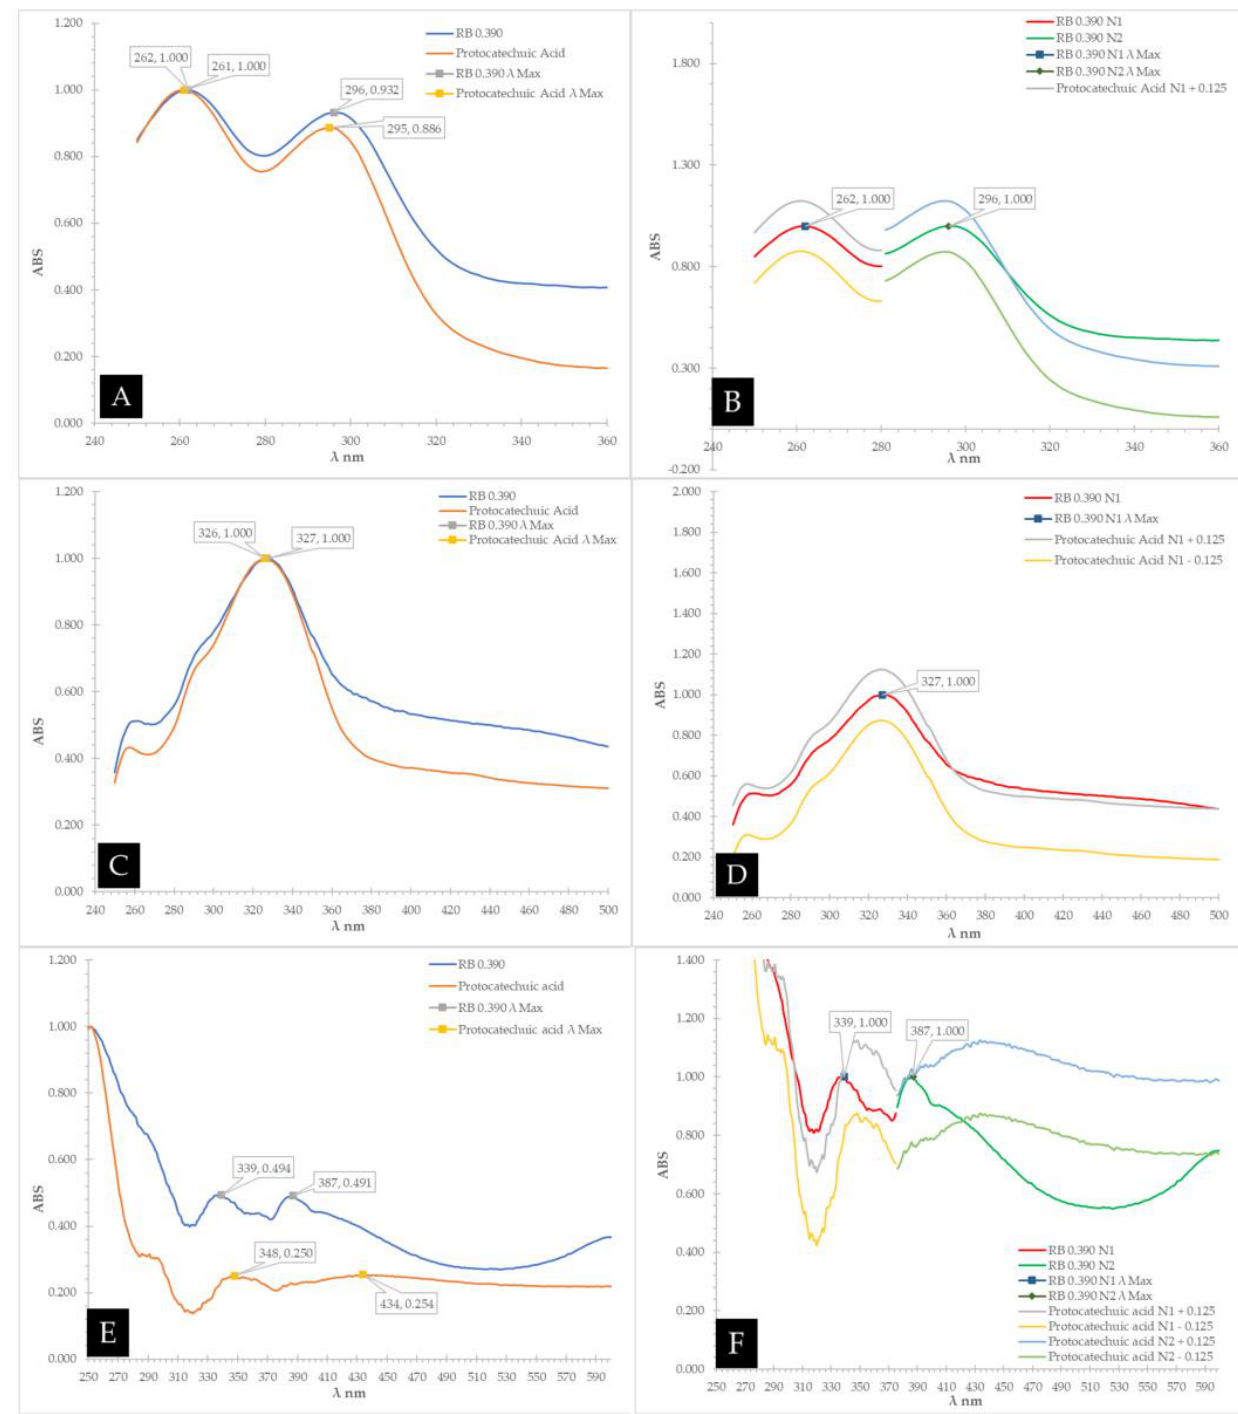
Figure 4. Spectra overlay of unknown band at Rf 0.390 in Calothamnus spp. (Red Bell) honey vs. protocatechuic acid ( 10 ) using MPB. ( A )—UV-Vis spectra and ( B )—overlay of the ± 0.125 AU comparison prior to derivatisation, ( C )—UV-Vis spectra, ( D )—overlay of the ± 0.125 AU comparison after derivatisation with NP-PEG, ( E )—UV-Vis spectra, ( F )—overlay of the ± 0.125 AU comparison after derivatisation with VSA.